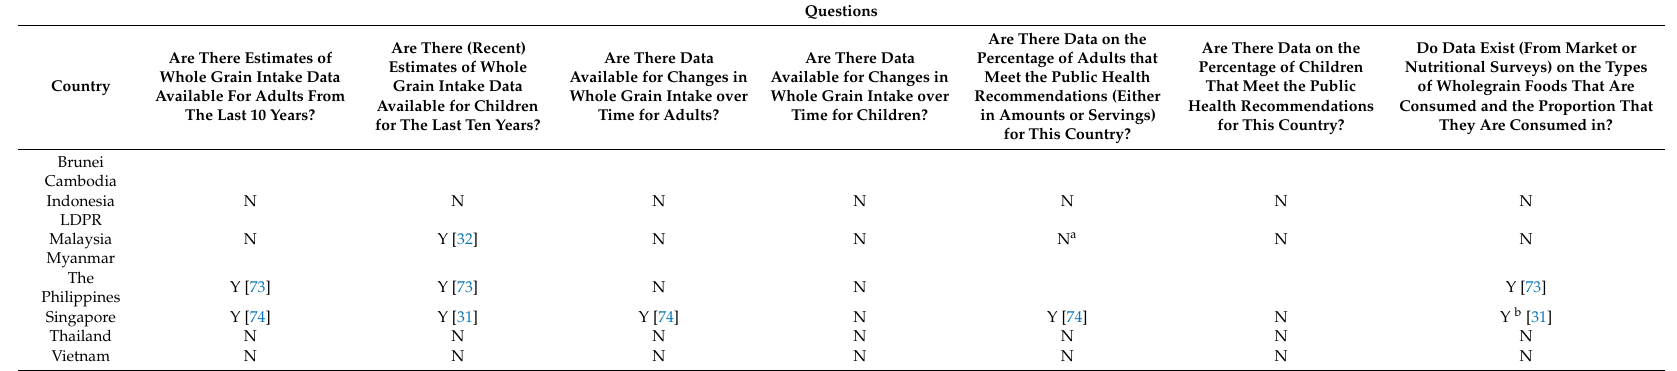
Table 5. Availability of intake data for whole grains across the ASEAN